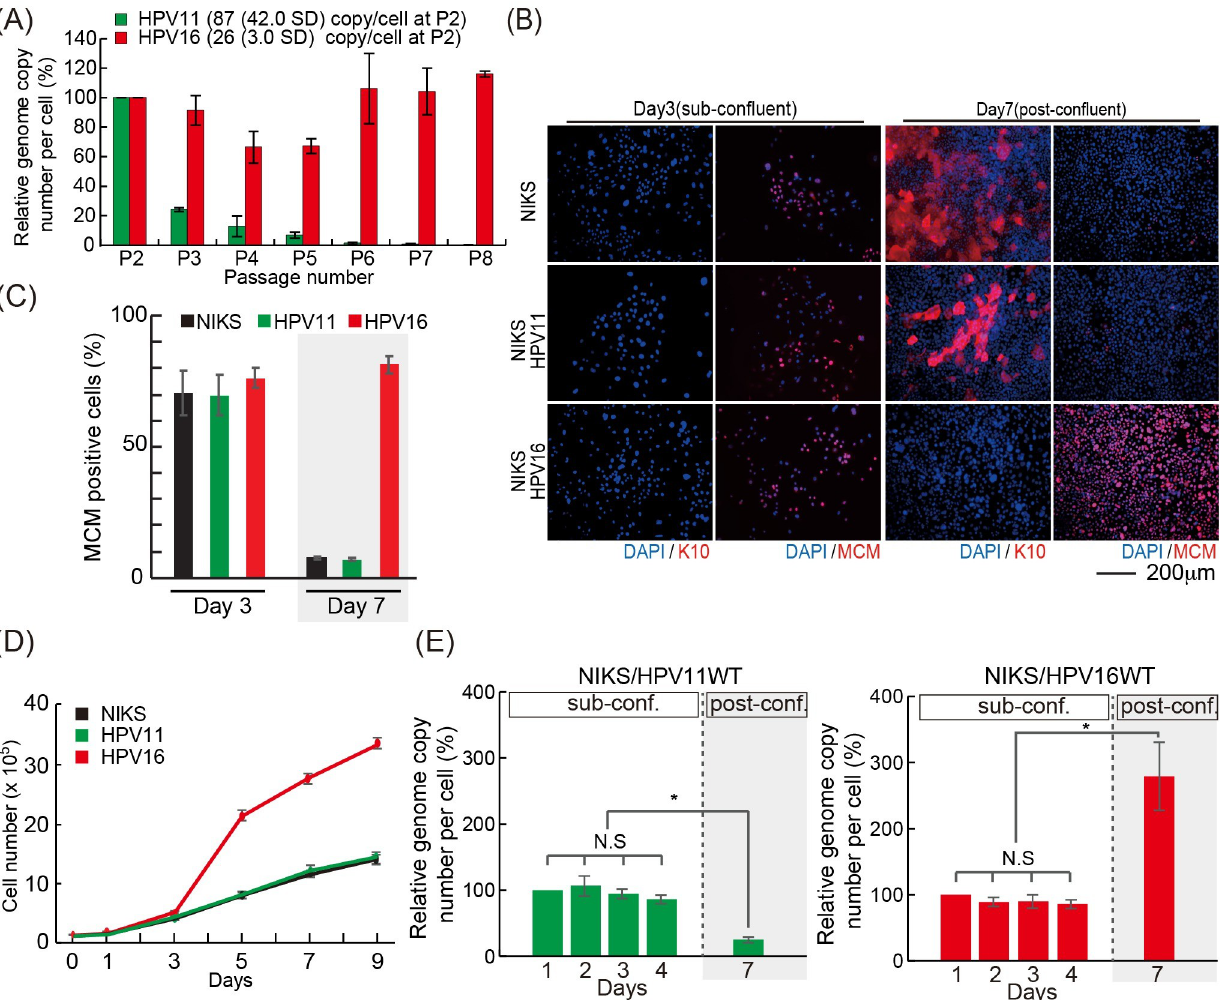
Fig 1. Difference between low and high-risk HPV types. (A) The viral genome copy number per cell was measured by qPCR, using the cellular GAPDH gene to estimate cell number. All DNA samples were digested with Dpn I to eliminate residual input DNA. The viral genome copy number per cell at passage 2 was set at 100%, and subsequent change in copy number normalized to this. HPV16 genome, but not HPV11, was well maintained until passage 8. The average viral genome copy number per cell at passage 2 is shown with standard deviation (SD). (B) NIKS or NIKS harboring HPV11 or HPV16 at days 3 and 7 were stained with K10 (red), to identify the early stage of differentiation; MCM (red), to identify the G1 and S phase compartments, and DAPI (blue) as a nuclear counterstain. Bar = 200 μ m. (C) Proportion of MCM positive cells at each time point is counted and shown. (D) NIKS, or NIKS harbouring HPV11 or HPV16 were counted in triplicate at days 1, 3, 5, 7 and 9 post-seeding. The cells were pre-confluent at day 3, confluent at day5 and post confluent at days7 and 9. (E) NIKS transfected with HPV11 (left) or HPV16 (right) were seeded at day 0, and collected at days 1, 2, 3 (pre-confluence), day 4 (confluence) and day 7 (post-confluence). The viral genome copy number per cell was measured as outlined in Fig 1A above. All DNA samples were digested with Dpn I to remove residual input DNA. The viral genome copy number per cell at each day 1 timepoint, was set at 100%. N.S. = no significant difference compared with each other. The single asterisk indicates P values of <